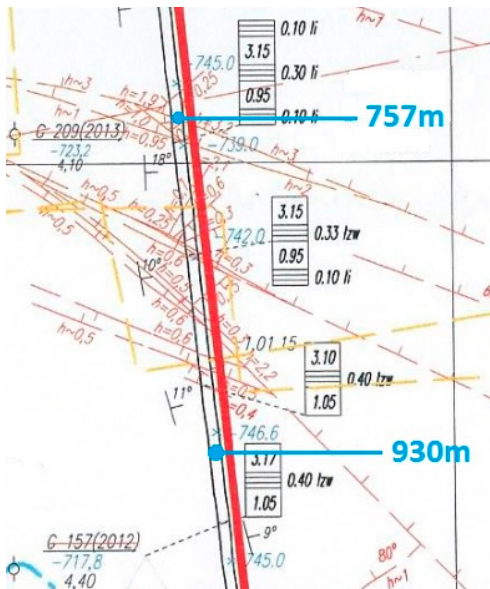
Figure 1. Faults position and the convergence stations in Maingate D-2; ( a ) The map of Maingate D-2 ( b ) The convergence stations layout.